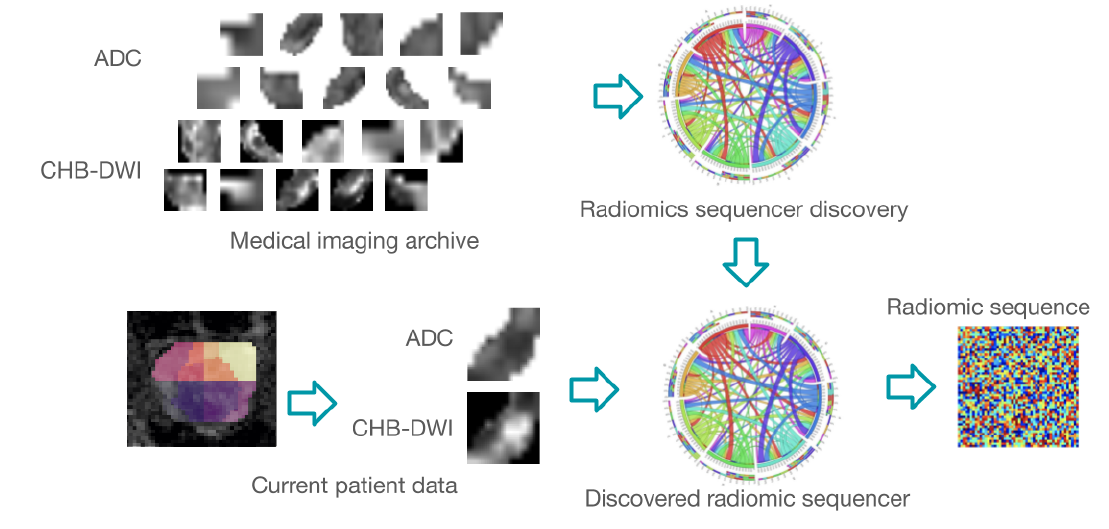
Figure 3. Overview of Zone-DR. For this study, radiomic sequencers were discovered via a two-part discovery radiomics strategy (machine-driven sequencer design discovery to discover the radiomic sequencer design, followed by data-driven sequencer parameter discovery to discover the parameters of the radiomic sequencer) for both ADC and CHB-DWI sensing modalities using a wealth of zone-level sensing data of the prostate gland across an archive of patient cases. Using the final discovered radiomic sequencers, zone-level sensing data of a current patient is passed through the discovered radiomic sequencers to produce radiomic sequences that characterize the tissue phenotype within the input zone based on information captured in the respective modality. The generated radiomic sequence can then be used to grade the input prostate